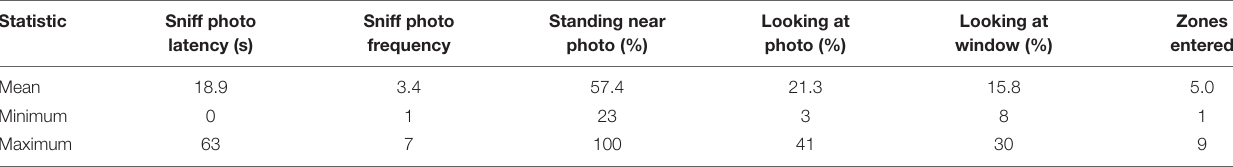
Sniff photo Standing near frequency photo (%)